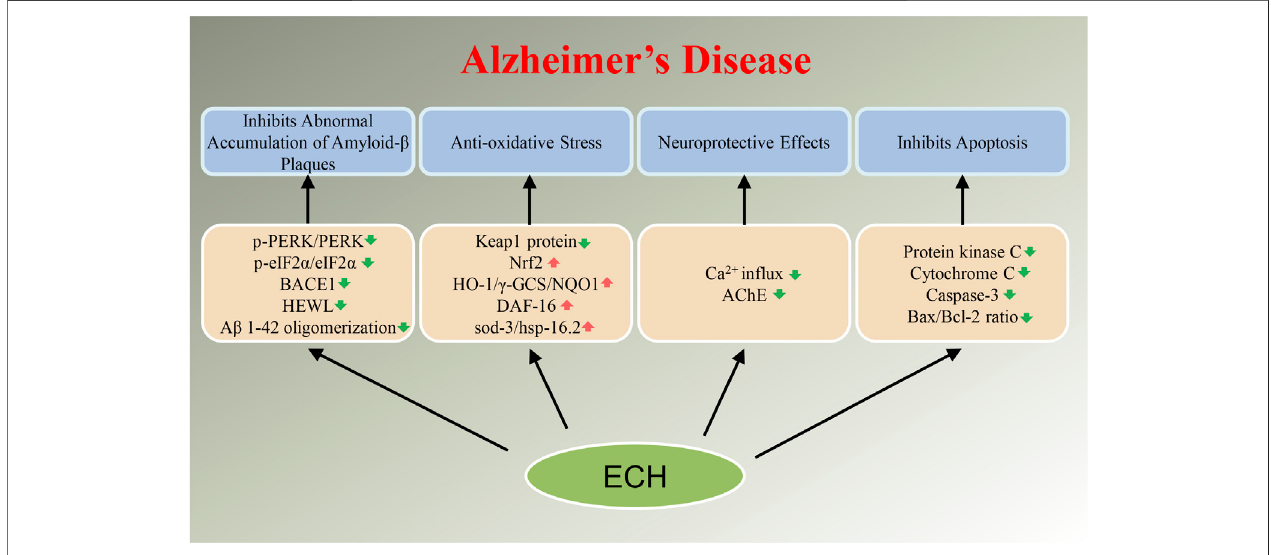
FIGURE 2 | Diagram with neuroprotective mechanisms of Echinacoside (ECH) in Alzheimer ’ s disease (AD). ECH can improve neurodegenerative diseases by regulating target genes or target proteins on abnormal accumulation of Amyloid- β plaques, oxidative stress, apoptosis, and neurotoxicity signaling pathways.